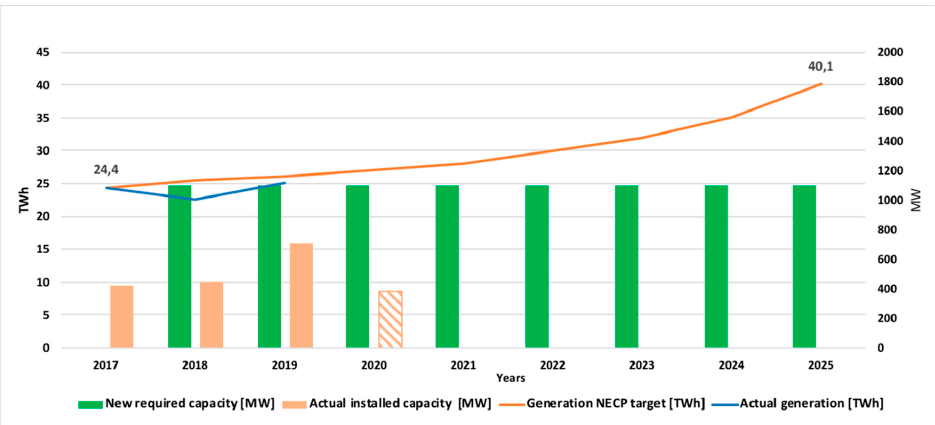
Figure 10. Solar generation capacity trajectories under NECP scenario and current trends [34].